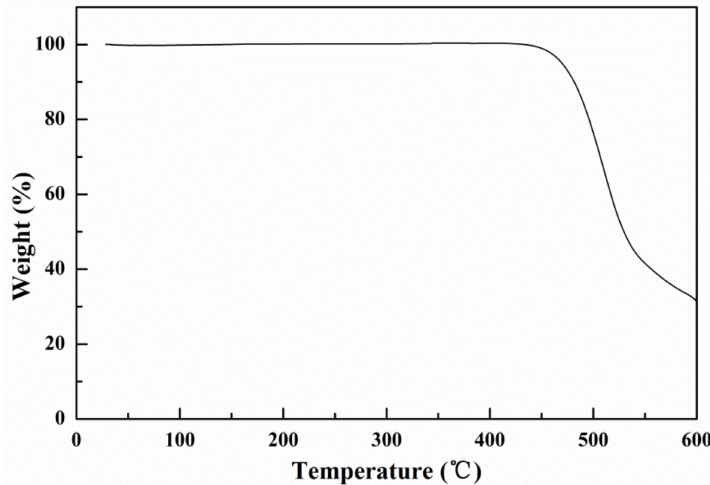
Figure 7. TGA curve of the oligomer BDT(DBTOTTH) 2